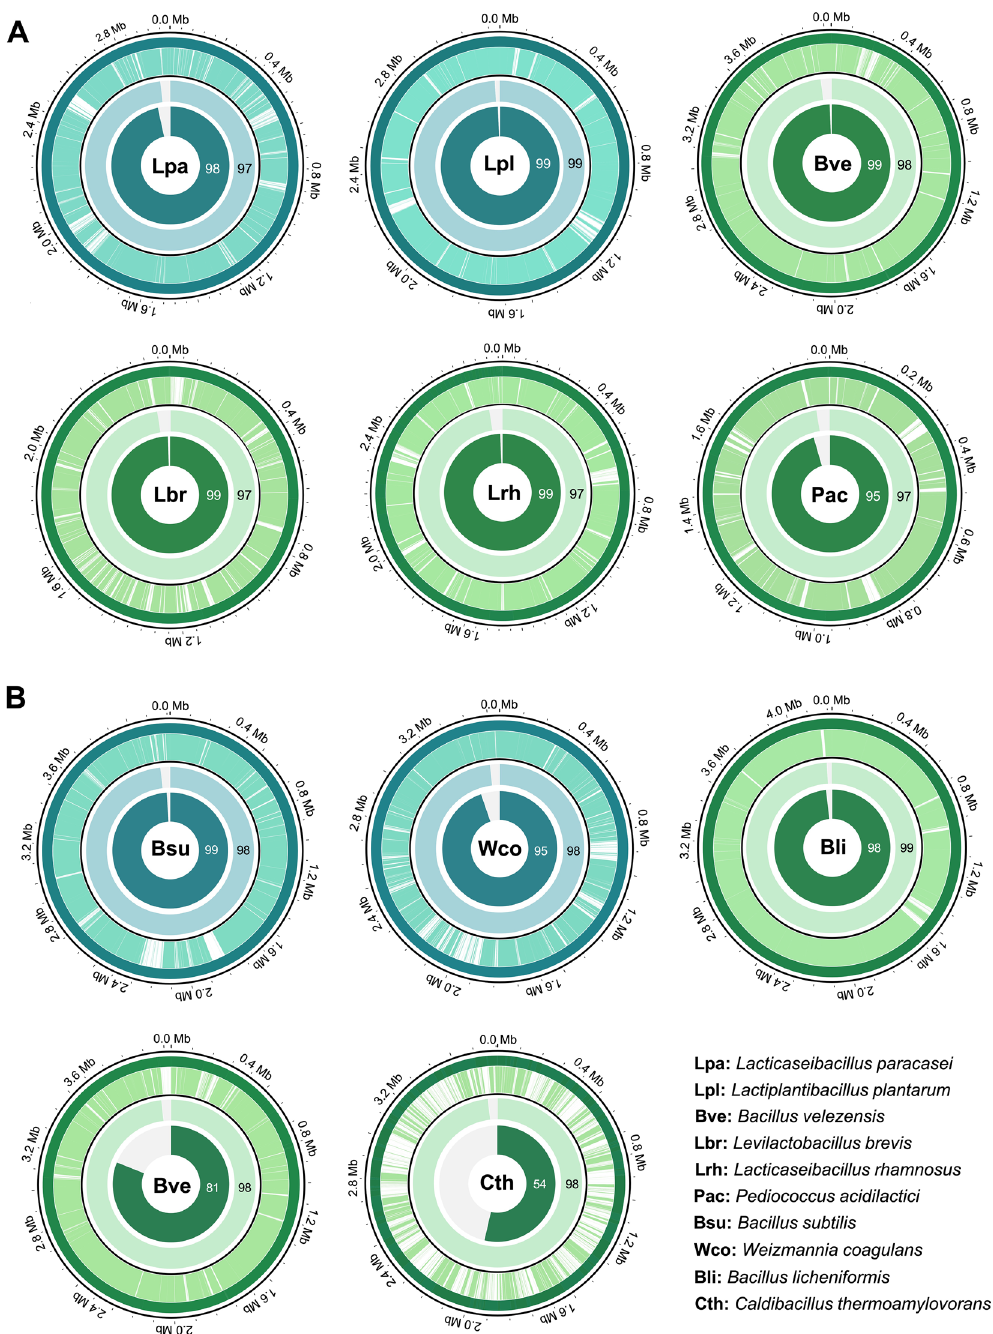
Figure 3. Metagenome-assembled genomes (MAGs) from animal probiotic products ( A , B ). Circos plot representation of features on the circular genome. Labelled and additional identified strains are shown in teal and sea green. The outer circle represents the complete genome of the closest strains. The distribution of MAG contigs all over the closest genome is located in the first inner circle. The whole-genome average nucleotide identity (ANI) percentage is calculated by FastANI and shown in the second inner circle. The percentage of completeness of the reconstructed genomes is indicated in the third inner